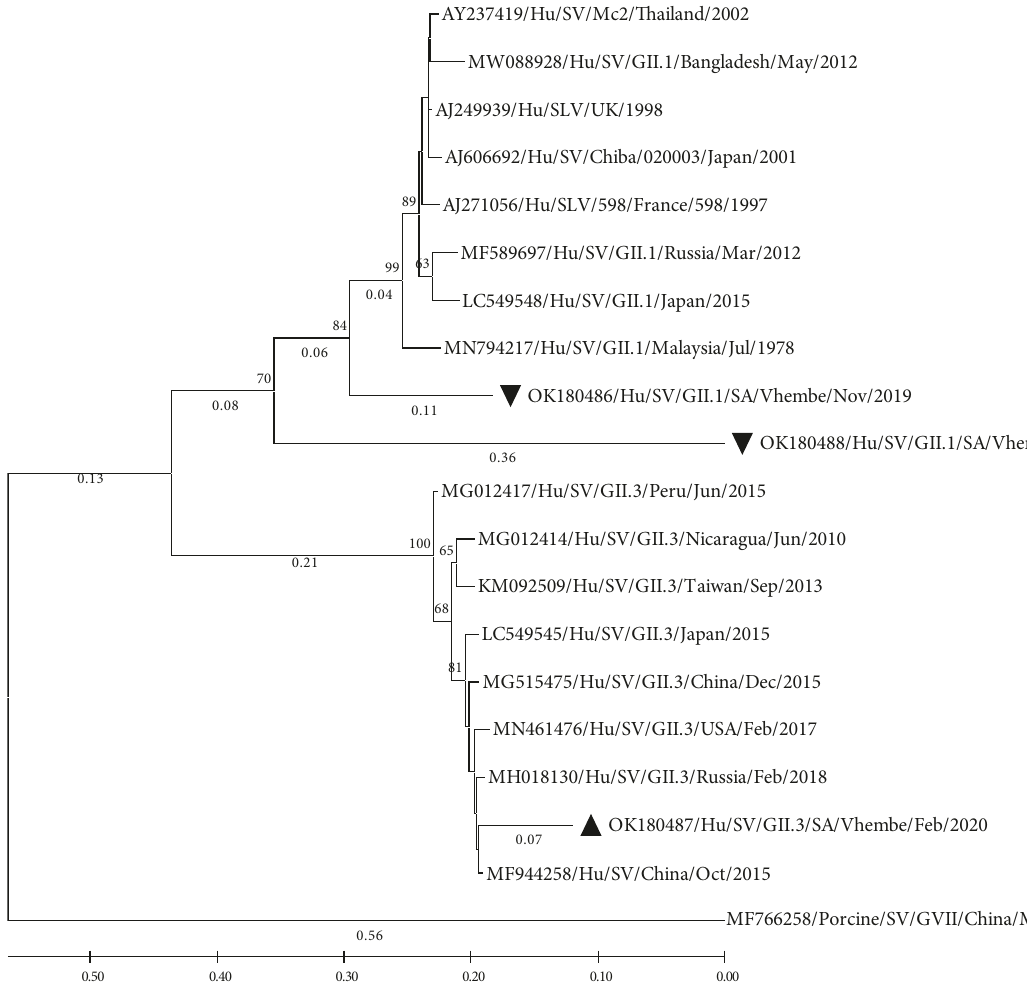
Figure 3: Phylogenetic analysis of the partial polyprotein of human SV-GII detected in Vhembe district, South Africa, and reference strains selected from the GenBank database. The percentage of replicate trees in which the associated taxa clustered together in the bootstrap test (1000 replicates) are shown next to the branches. A bar scale representing a genetic distance scale. The phylogenetic tree was deduced by the maximum likelihood method and the Kimura 2-parameter model using MEGA 11 [20, 21], based on a 644-nucleotide sequence fragment. The porcine SV (MF766258) was selected as an outgroup